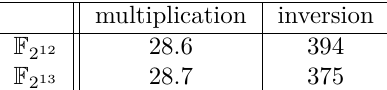
Table 7: Cycle counts for one multiplication and one inversion with the radix-16 repre- sentation. For the cycle counts for multiplication, we perform 128 multiplications in our assembly function and divide the resulting cycle counts by 128 to avoid the function call